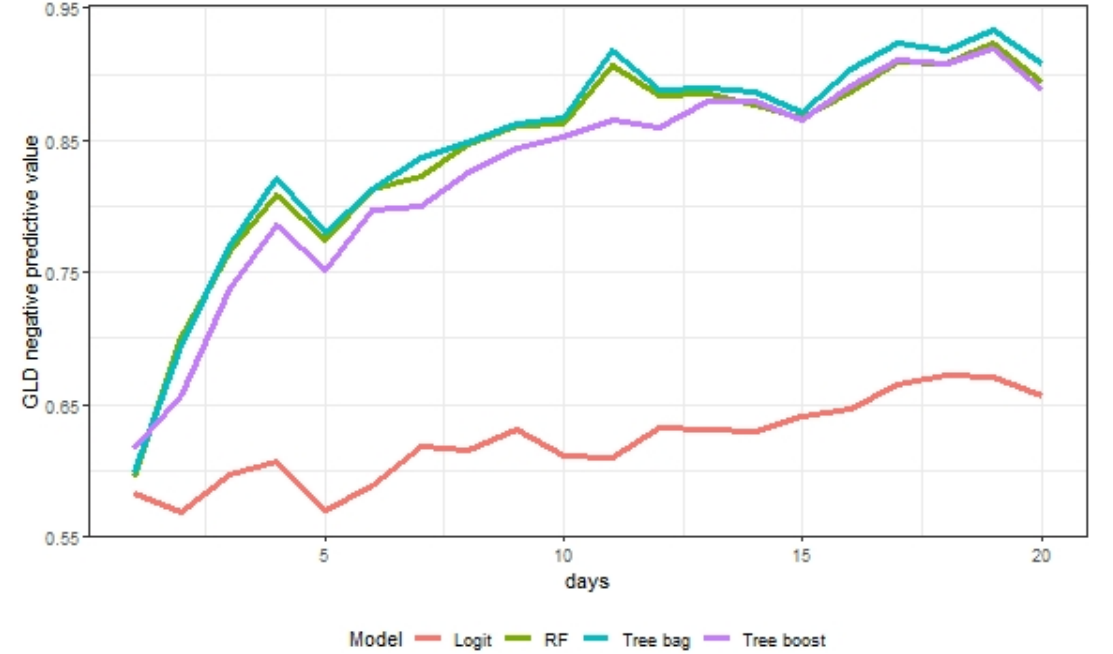
Figure 10. This figure shows the multi-period negative predictive value for GLD price direction.